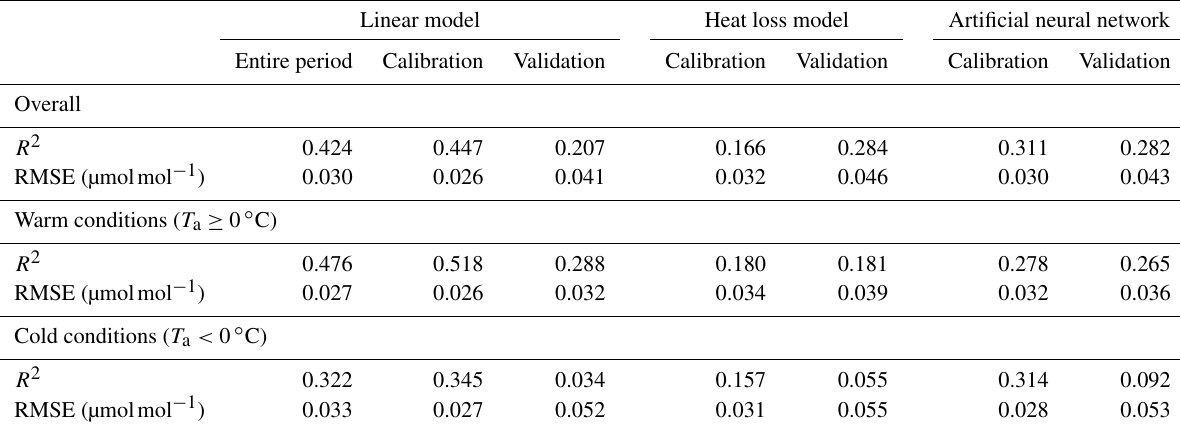
Table 1. Goodness of fit of TGS 2600 (sensor 1)-derived CH 4 mole fractions (30min averages) obtained from a linear model using air temperature and absolute humidity (Eq. 2), a heat loss model (Eq. 3), and an artificial neural network (ANN). For the goodness of fit the coefficient of determination ( R 2 ) and the root mean square error (RMSE) of the residuals are reported for the overall model and separately for warm and cold conditions. The parametrization of the linear model given in Eq. (2) used the entire 2012–2018 period. For a more rigorous model test, all three approaches were calibrated with the data measured in years 2014–2016, and the remaining data (2012–2013 and 2017–2018) were used for